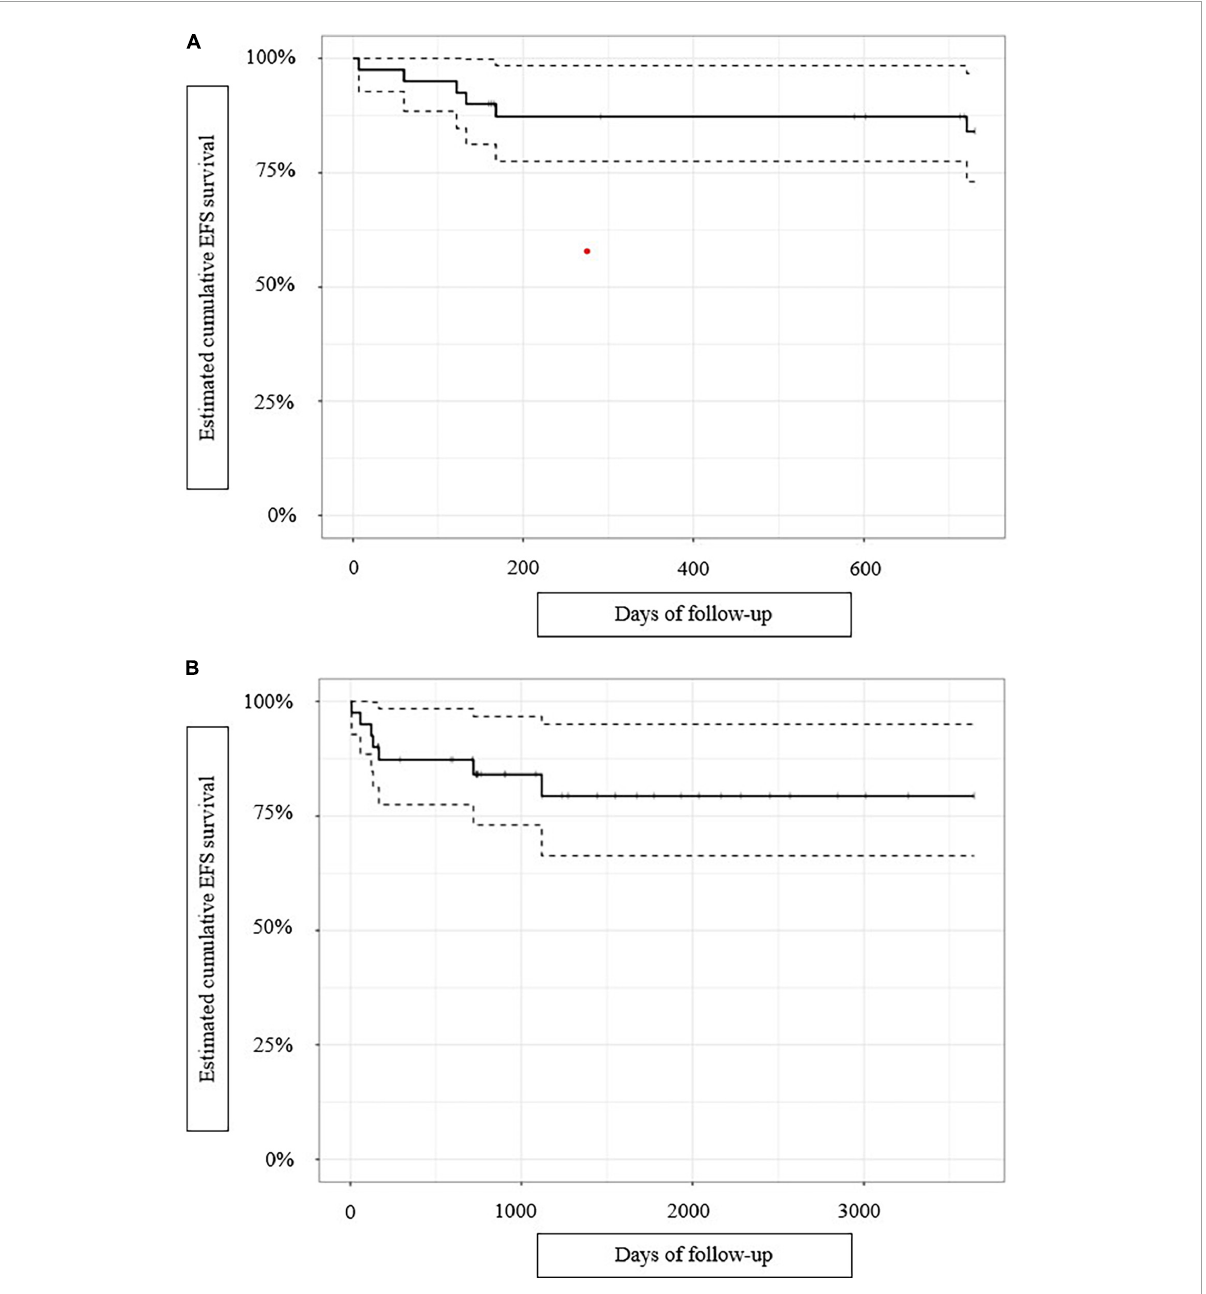
FIGURE1 For 40 patients curatively treated for P. aeruginosa prosthetic joint infections, Kaplan–Meier-estimated: (A) cumulative 2-year event-free survival (EFS), and (B) cumulative end-of-follow-up event-free survival. The dashed lines indicated the confidence intervals.